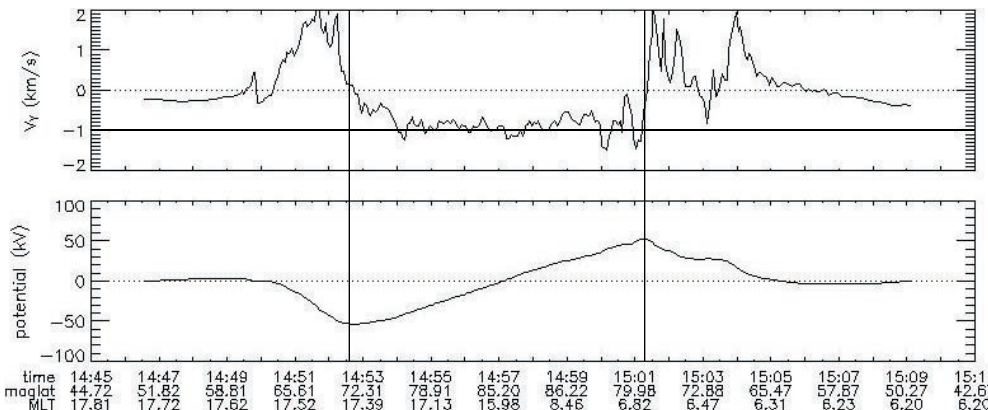
Fig. 4. DMSP F13 data showing cross-track ion drift ( V y ) and electrostatic potential (bottom) for the interval 14:45–15:11UT. Polar cap dusk- and dawn-side boundaries are marked by vertical